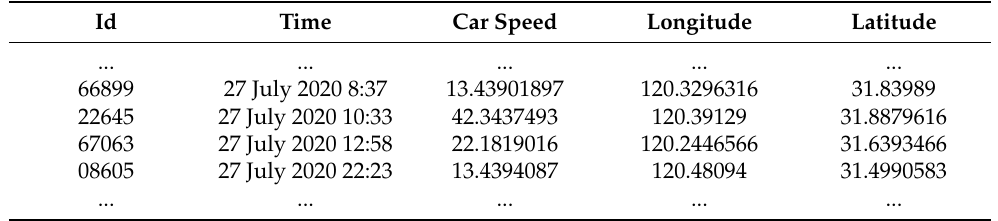
Table 3. Partial data of car